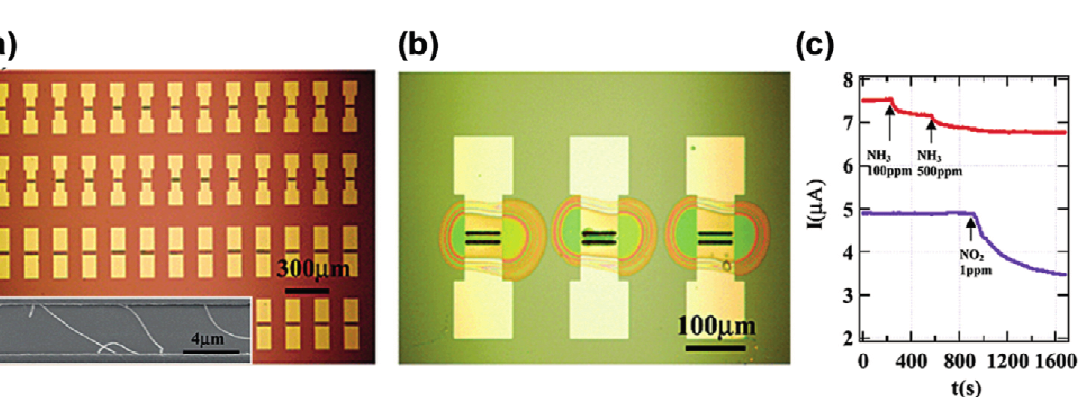
Figure 5. ( a ) Optical image of an array of multiple-SWNT devices. The inset is SEM image of several nanotubes bridging two opposing Mo electrodes in a device; ( b ) Optical image showing three multiple-tube (MT) devices after microspotting with droplets of polymer solutions; ( c ) Red (top) curve: a device coated with Nafion exhibited a response to in air, and no response when 1 ppm of NO was introduced to the 100 and 500 ppm of NH 3 2 environment. Blue (bottom) curve: a PEI-coated device exhibiting no response to 100 and and large conductance decrease for 1 ppm of NO 500 ppm of NH 3 2